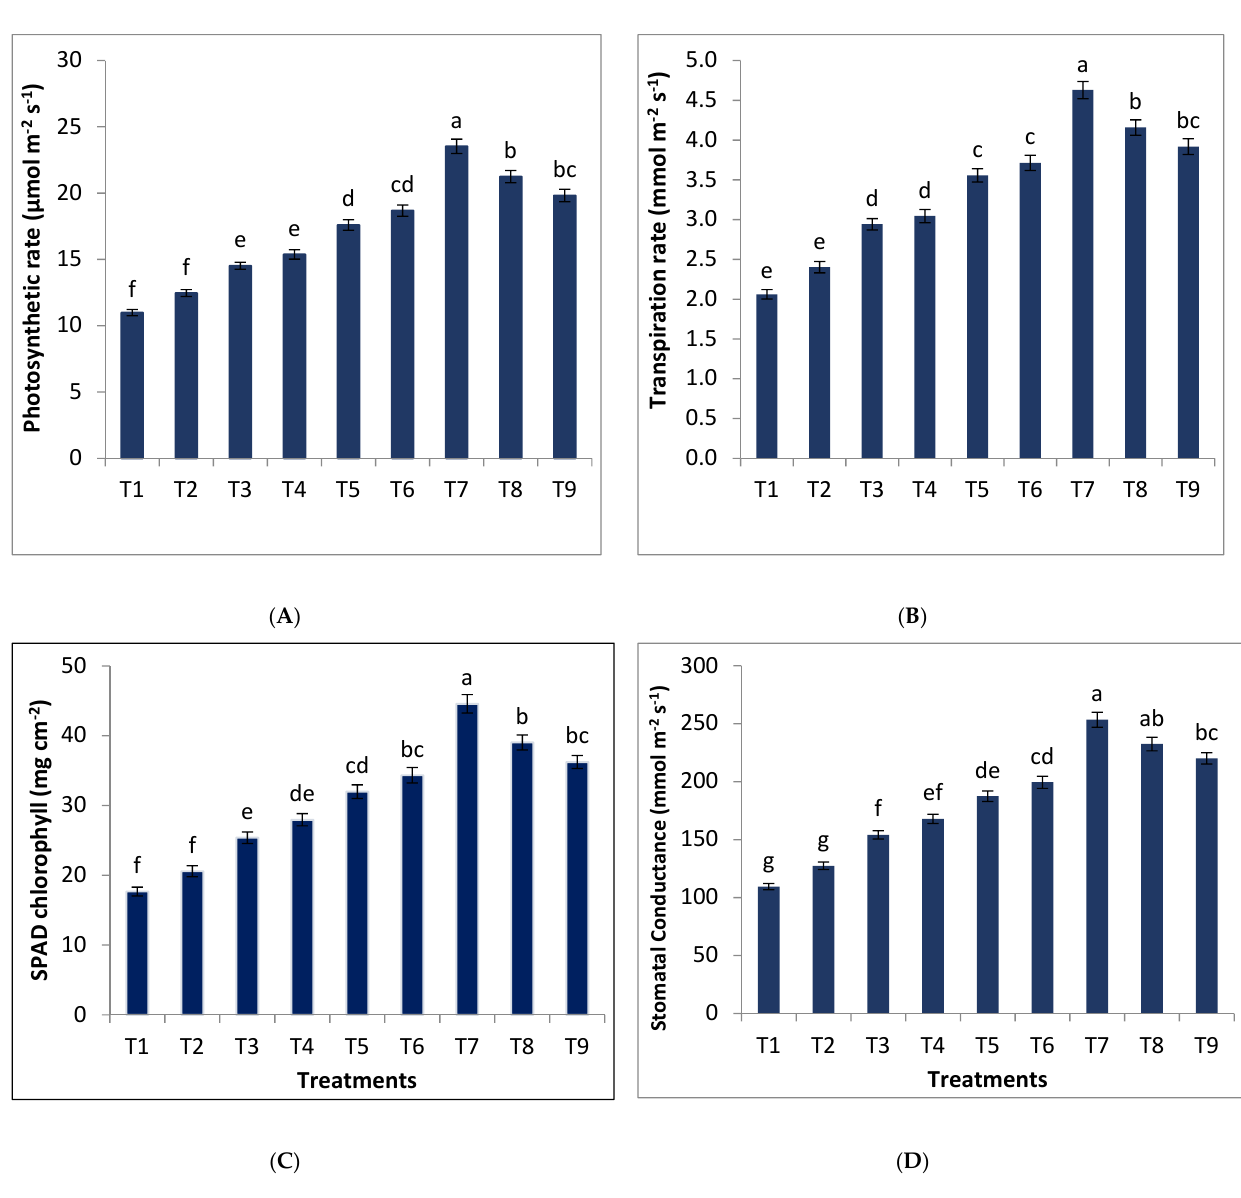
Figure 3. Effect of different combinations of bio-activated rock-phosphate (B-RP) and di-ammonium phosphate (DAP) on photosynthetic rate ( A ), transpiration rate ( B ), SPAD chlorophyll ( C ) and stomatal conductance ( D ) of wheat. Bars sharing similar letters do not differ significantly at P < 0.05; The standard error (SE) represents variation of population mean from sample mean ( n = 3); T1: Control (0% P), T2: RP (100% P), T3: AM (100% P), T4: PM (100% P), T5: B-RP (100% P), T6: B-RP (75% P) + DAP (25% P), T7: B-RP (50% P) + DAP (50% P), T8: B-RP (25% P) + DAP (75% P), T9: DAP (100% P). RP: Rock phosphate, AM: Animal manure, PM: Poultry manure, B-RP: Bio-activated rock phosphate, DAP: Diammonium phosphate.